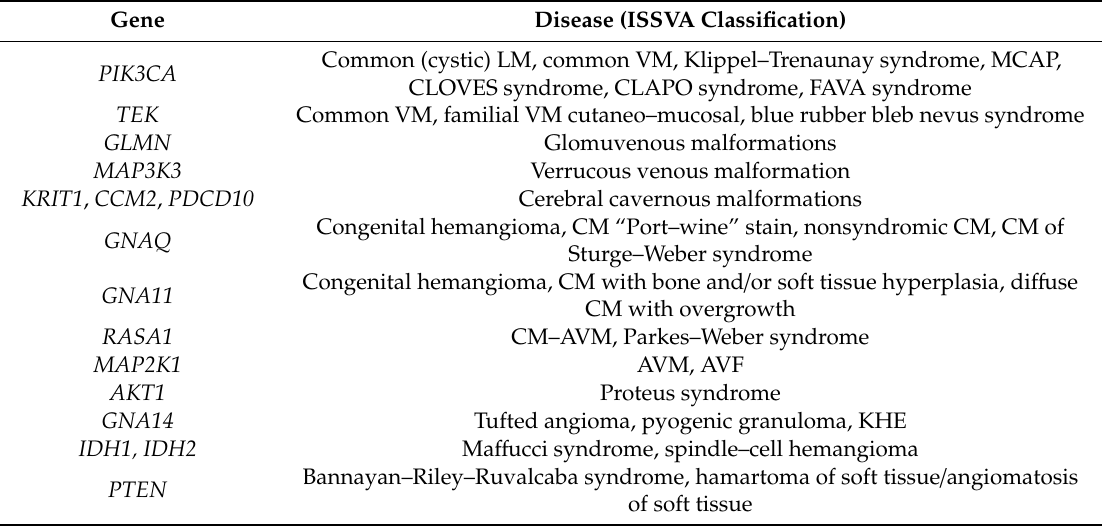
Table 1. Genes analyzed with corresponding